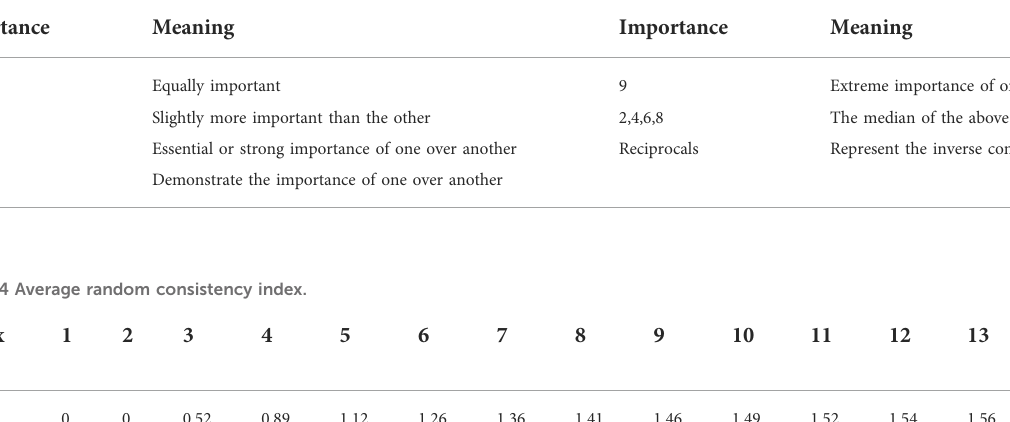
TABLE 3 1 – 9 meaning of scale.